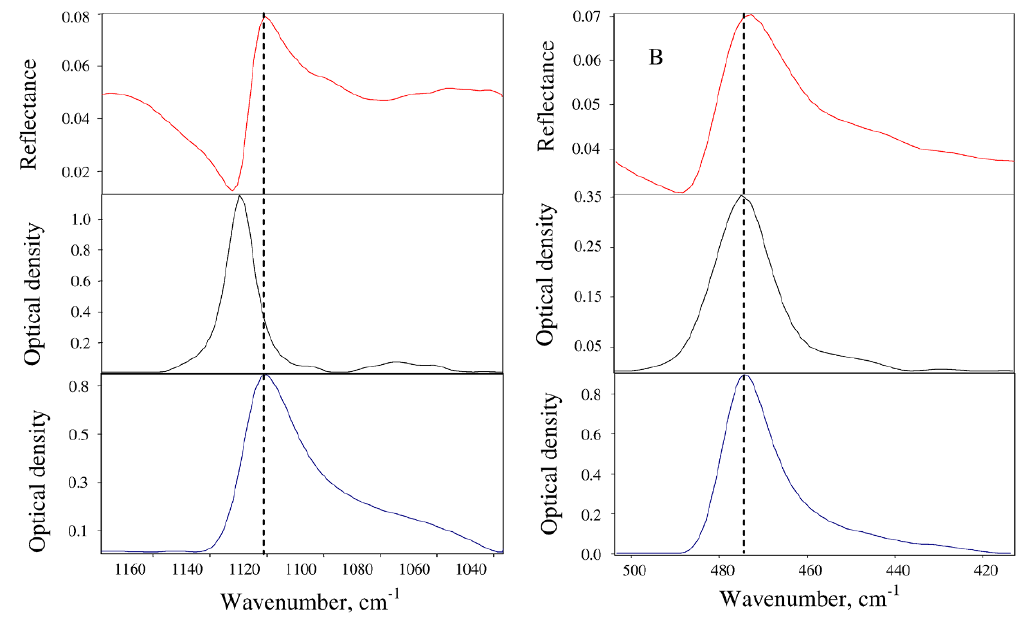
Figure 3. Characteristic uric acid bands in the MIR (A) and FIR (B) : top – experimental reflection spectrum; middle - KKT corrected spectrum; bottom – reference absorption spectrum (KBr or PE pellet,